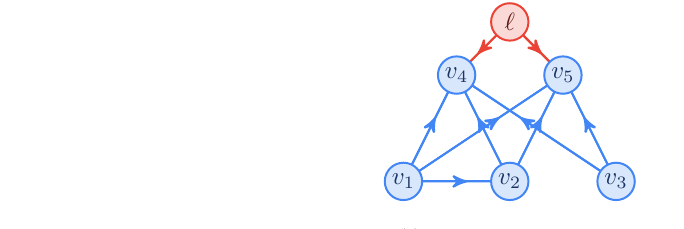
Figure 19: The exogenized causal structure exo G 18